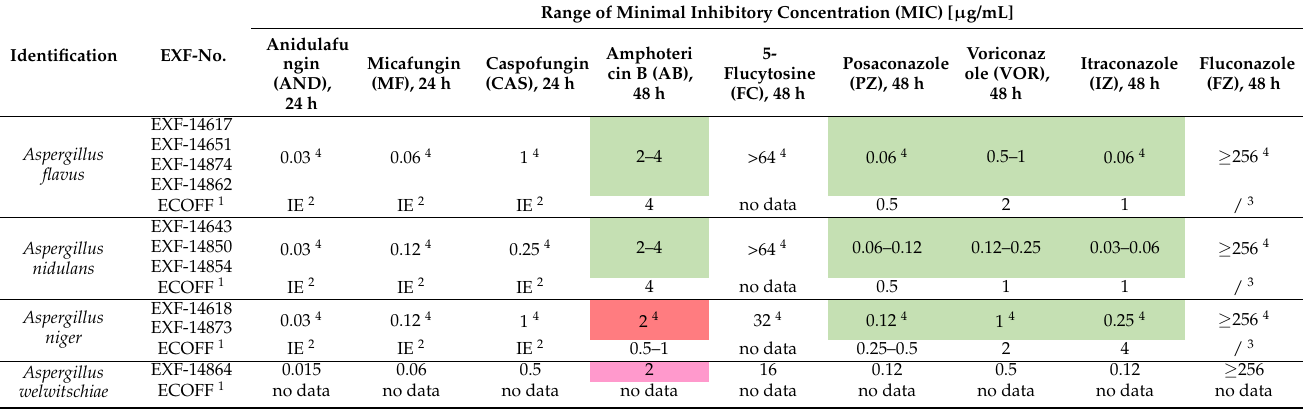
Table 2. The results of susceptibility testing for Aspergillus species isolated during bathing season against nine antifungals from Sensititre Yeast One